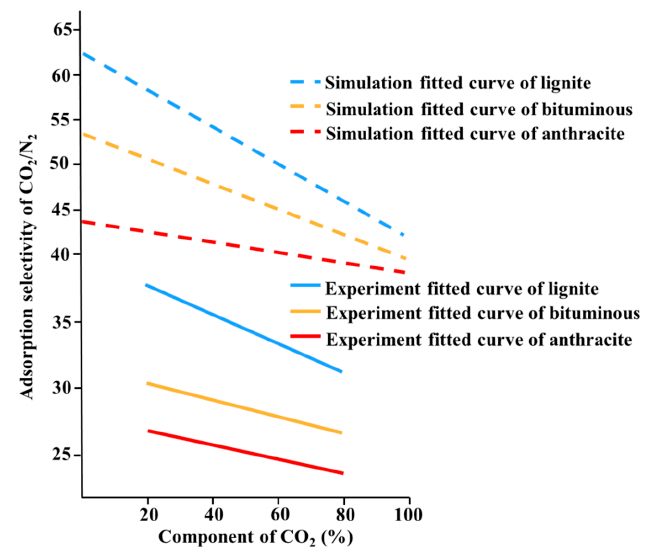
Figure 9. Adsorption selectivity during CO 2 /N 2 injection into lignite, bituminous and anthracite based on simulations and experimental work. A selectivity value larger than 1 indicates preferential adsorption of CO 2 . Modified from [99].